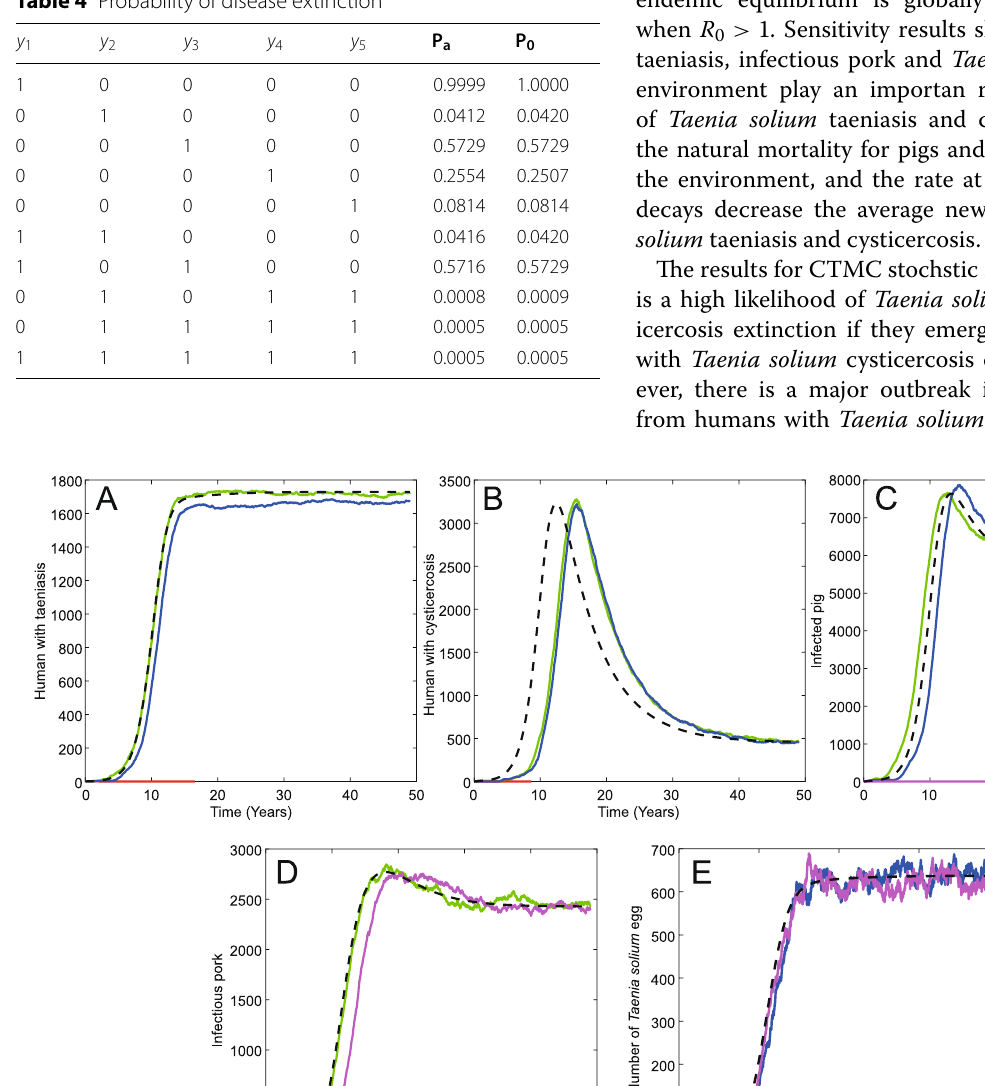
Table 4 Probability of disease extinction